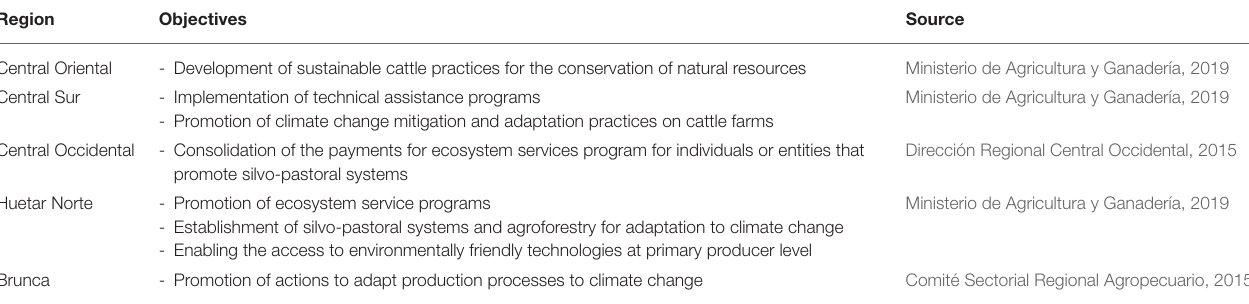
TABLE 5 | Regional level development objectives for a sustainable Costa Rican cattle sector.